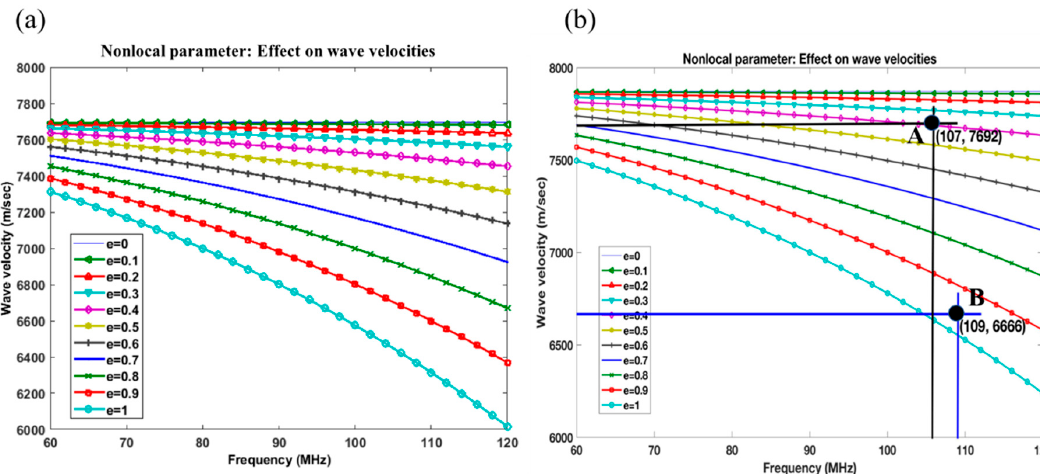
Figure 12. Dispersion relationship of quasi-longitudinal wave mode resulting from intrinsic length scale effects ( ε ls = 0 to 1) ( a ) with piezo stiffening and ( b ) without piezo stiffening at frequency 60 MHz–120 MHz.